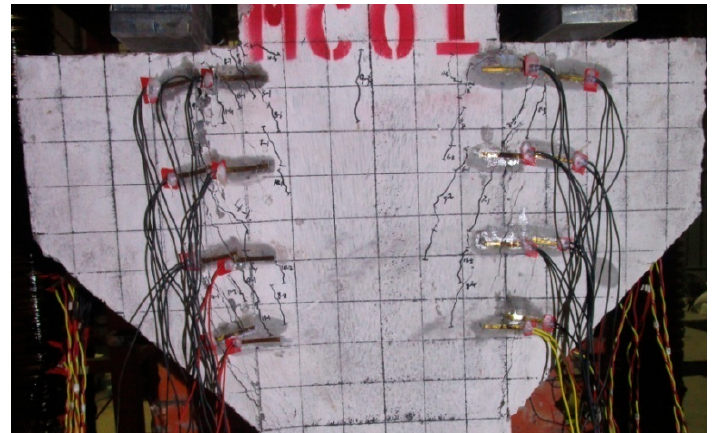
Figure 2. Failure behavior of the MC01 specimen.